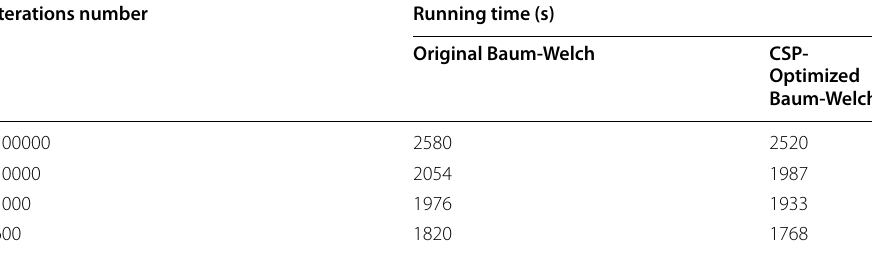
Table 5 Running time comparison of Baum-Welch algorithm Iterations